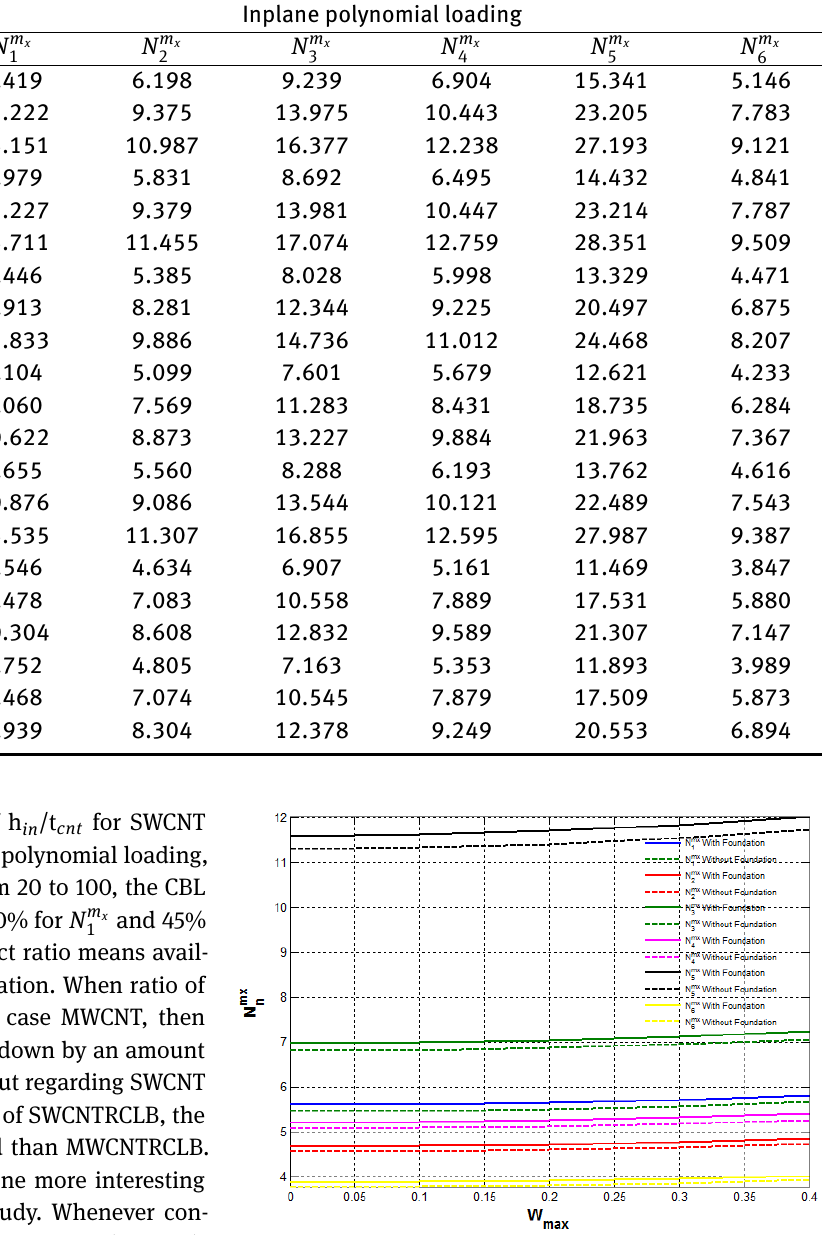
Table 5: Effect of MWCNT, its thickness and aspect ratio on CBL analysis N w h in /t cnt l/d mo